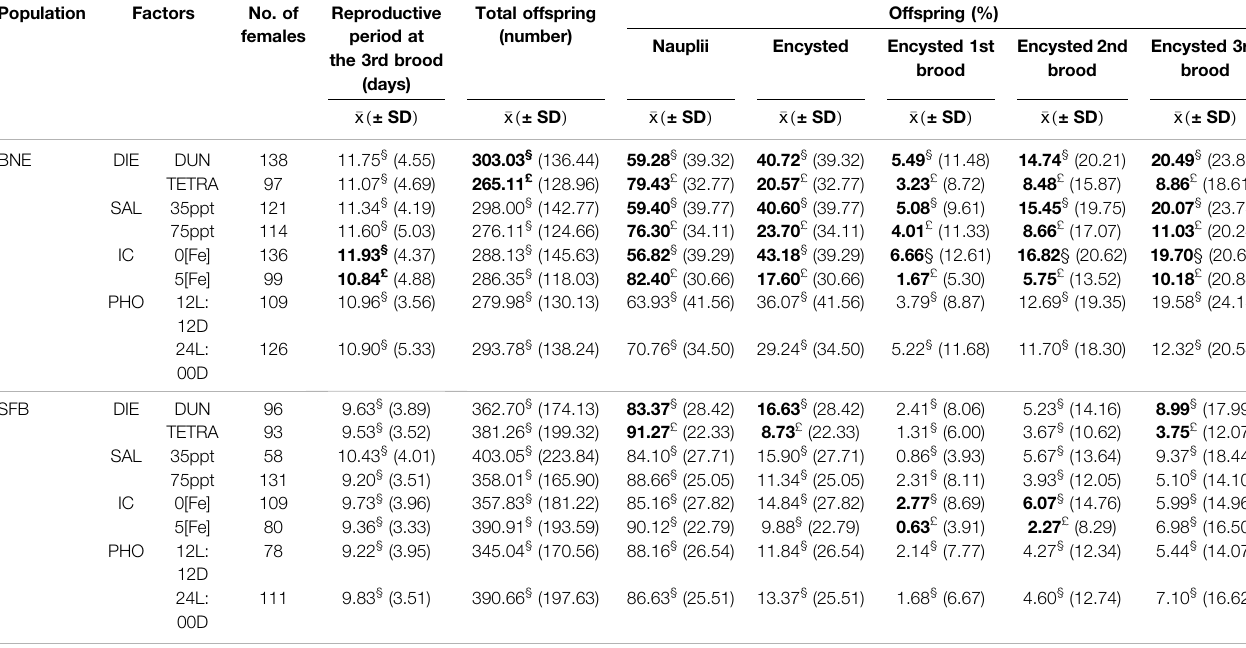
TABLE 5 | Summary of reproductive parameters recorded for four factors in Barro Negro (BNE) and San Francisco Bay (SFB) populations. Population